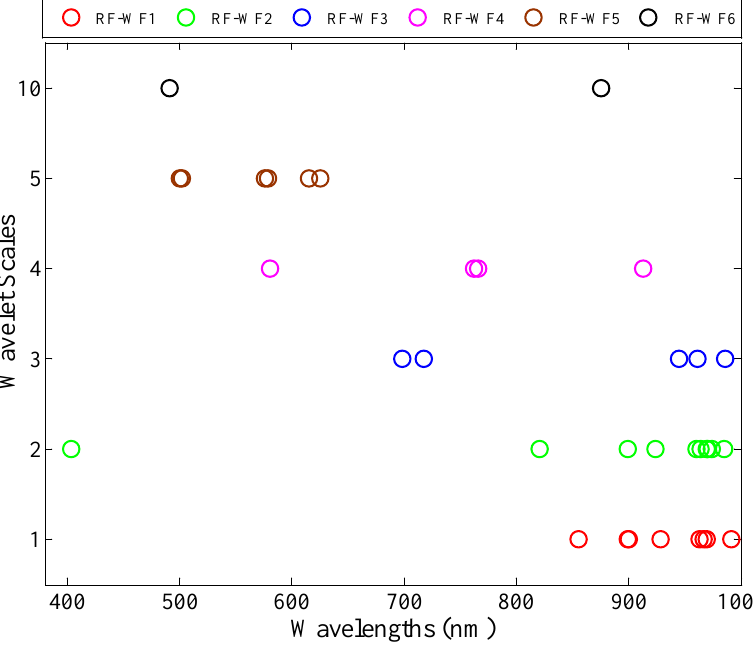
Figure 10. Location of growth stage sensitive wavelet features selected by random frog (RF).